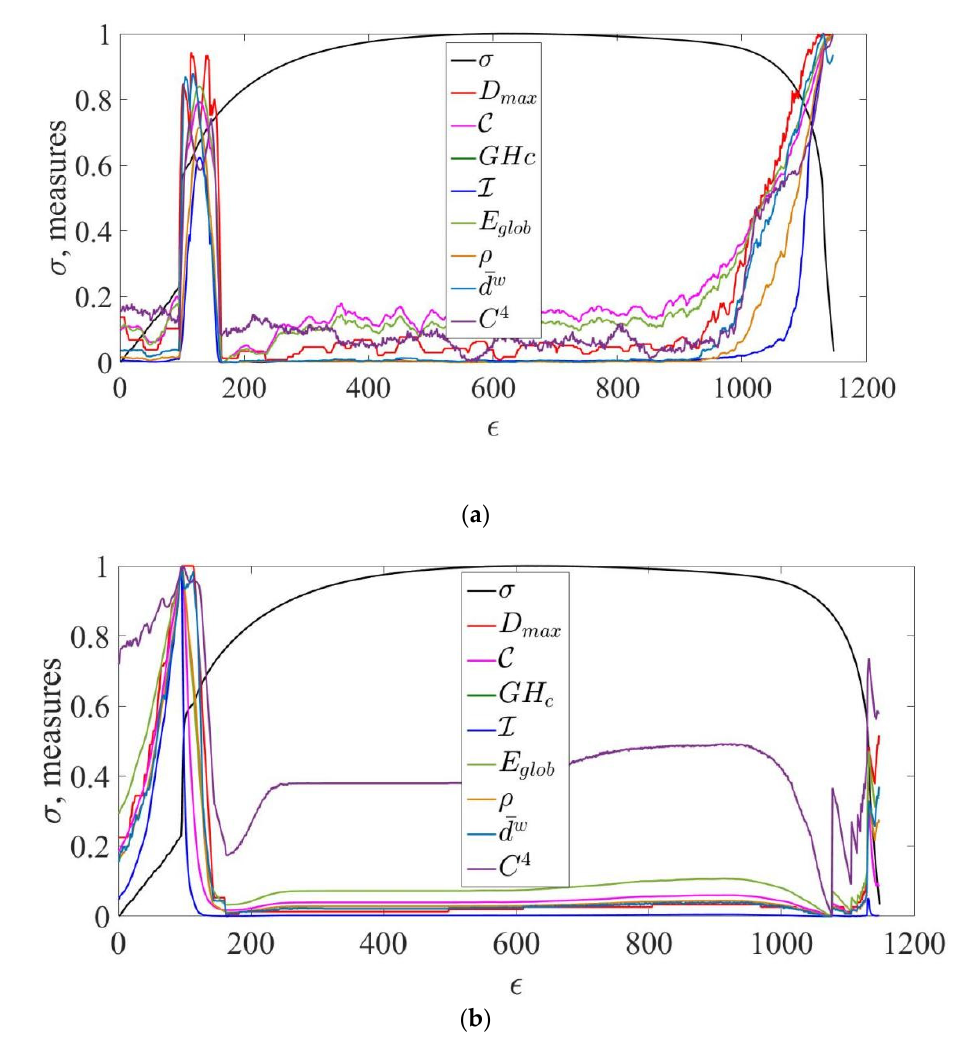
Figure 5. The dynamics of maximum node degree ( D max ), global closeness centrality ( C ), global harmonic centrality ( GHc ), overall network information centrality ( I ), global efficiency ( E glob ), density ( ρ ), average degree connectivity ( d ), and squares clustering coefficient ( C 4 ) based on the VG ( a ) and the RP ( b ) approaches for the stress–strain time series.